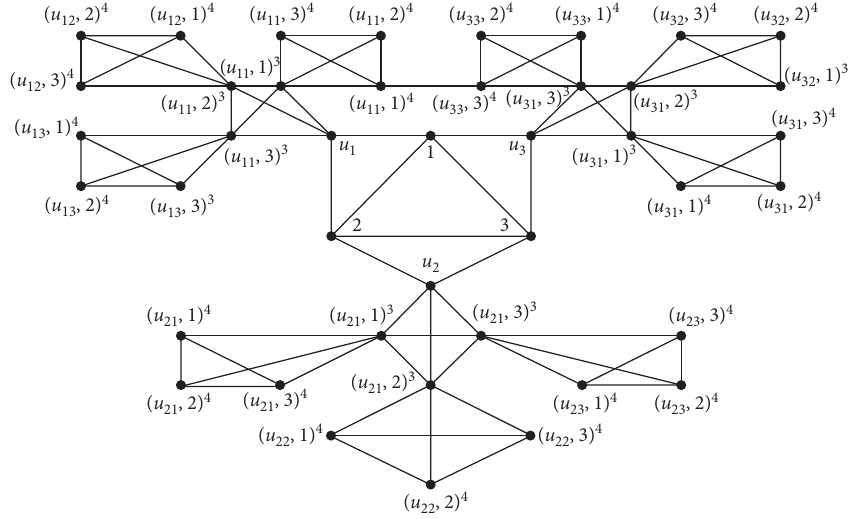
Figure 2: The line graph